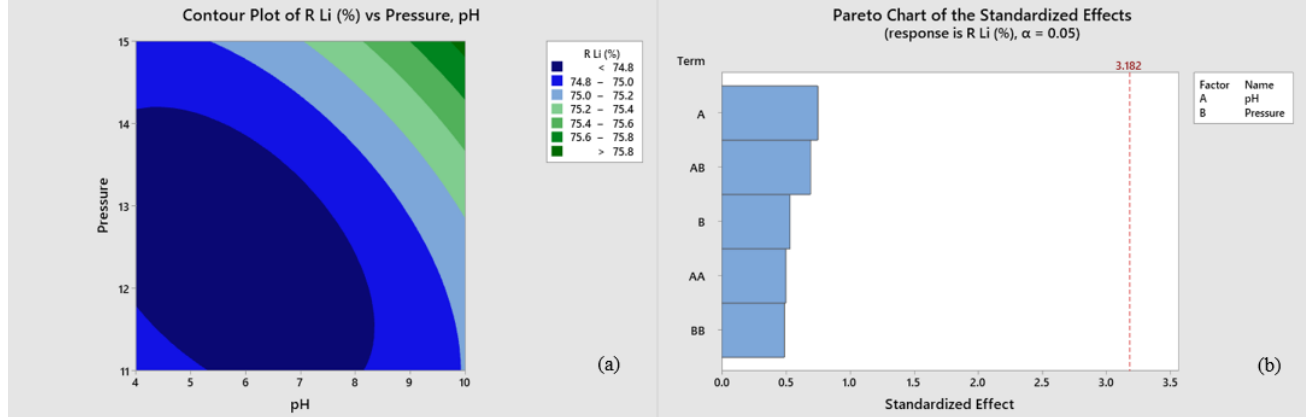
Figure 6. Statistical approximation diagram of standard effects for optimizing experimental variables. ( a ) Contour diagram. ( b ) Pareto